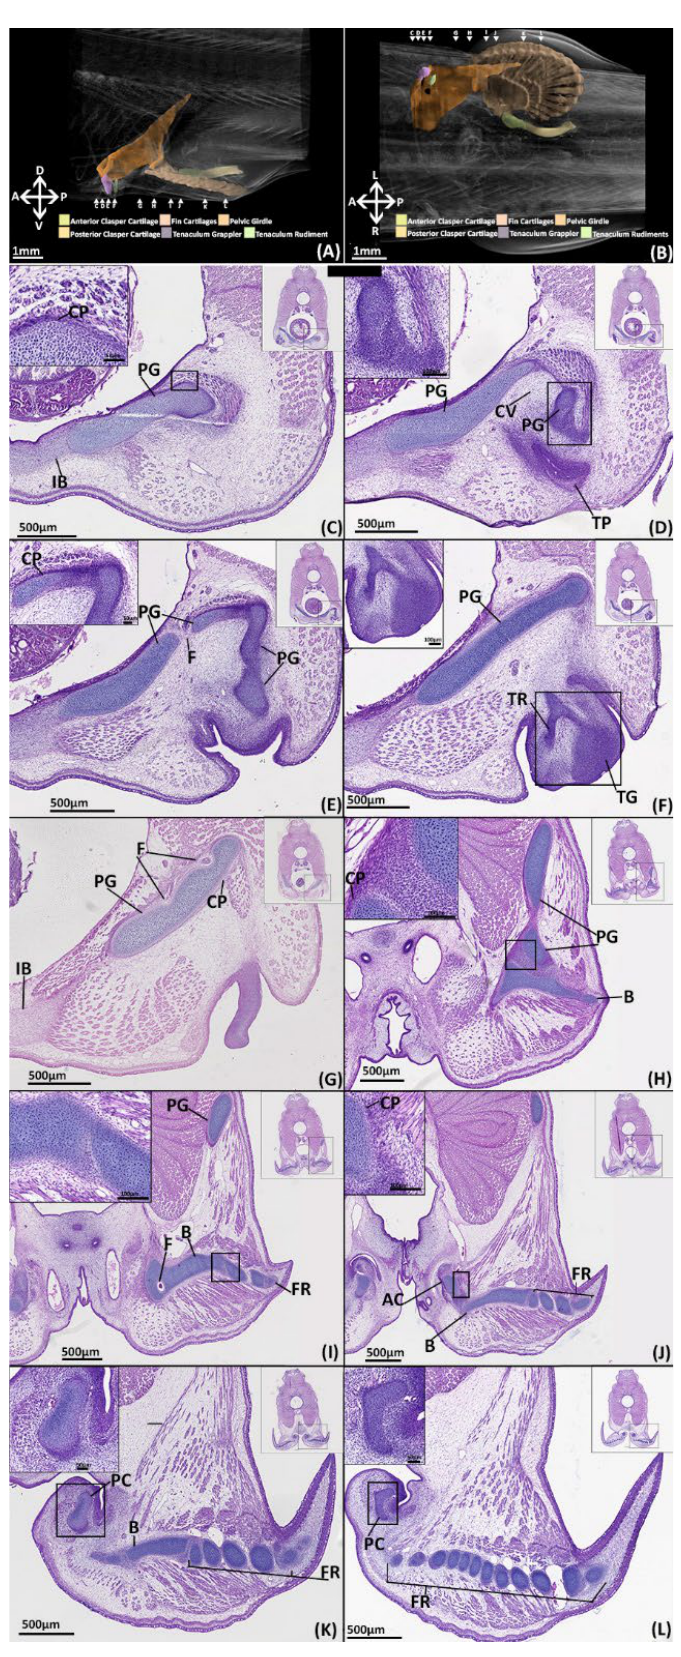
Figure 7. NanoCT models ( A , B ) and transverse paraffin sections ( C – L ) of a male stage 34